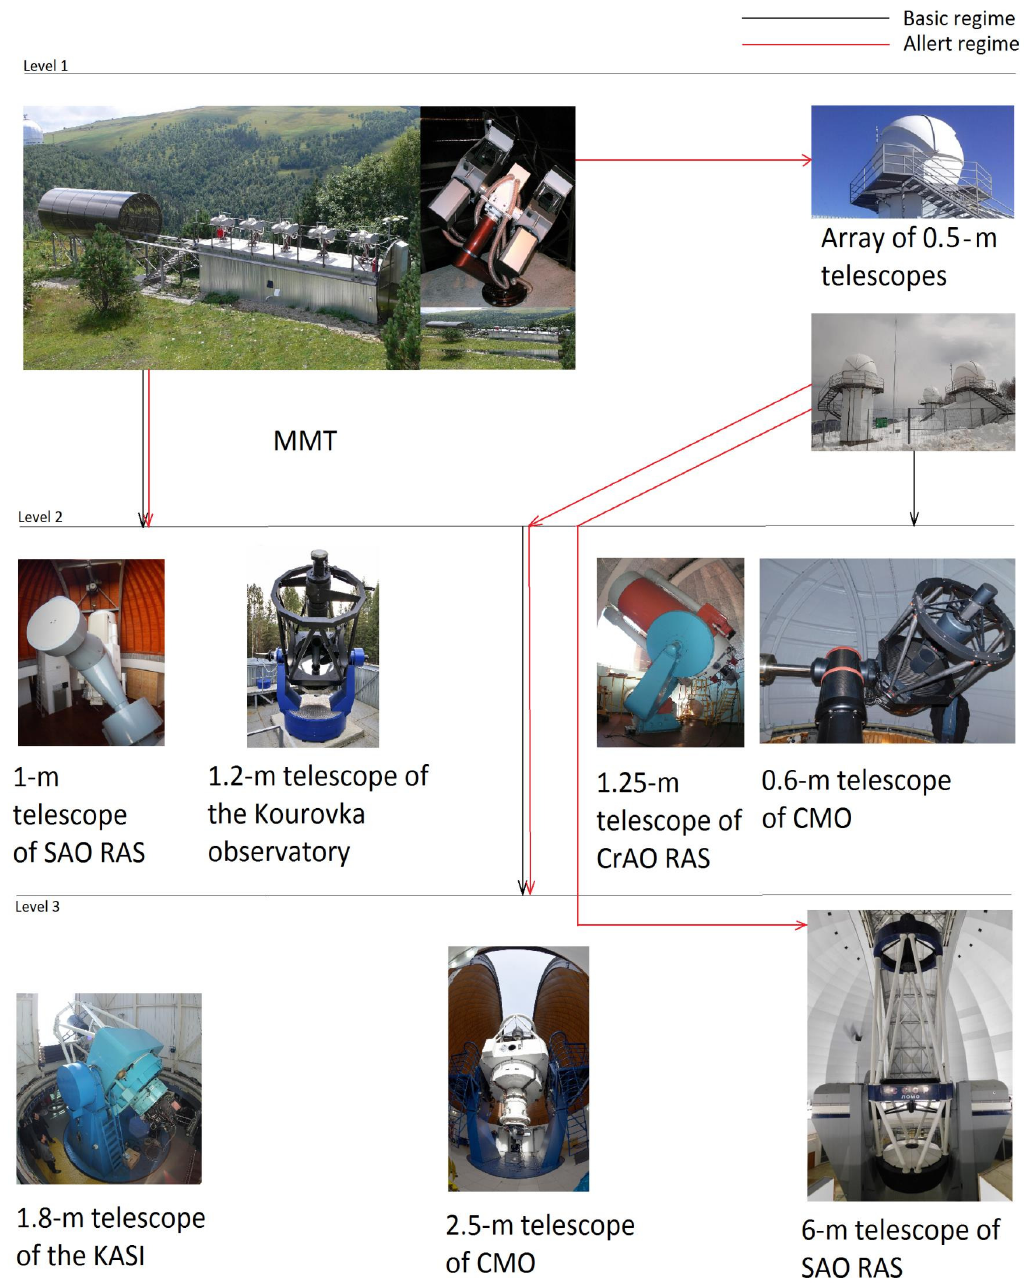
Figure 7. Explanation operating